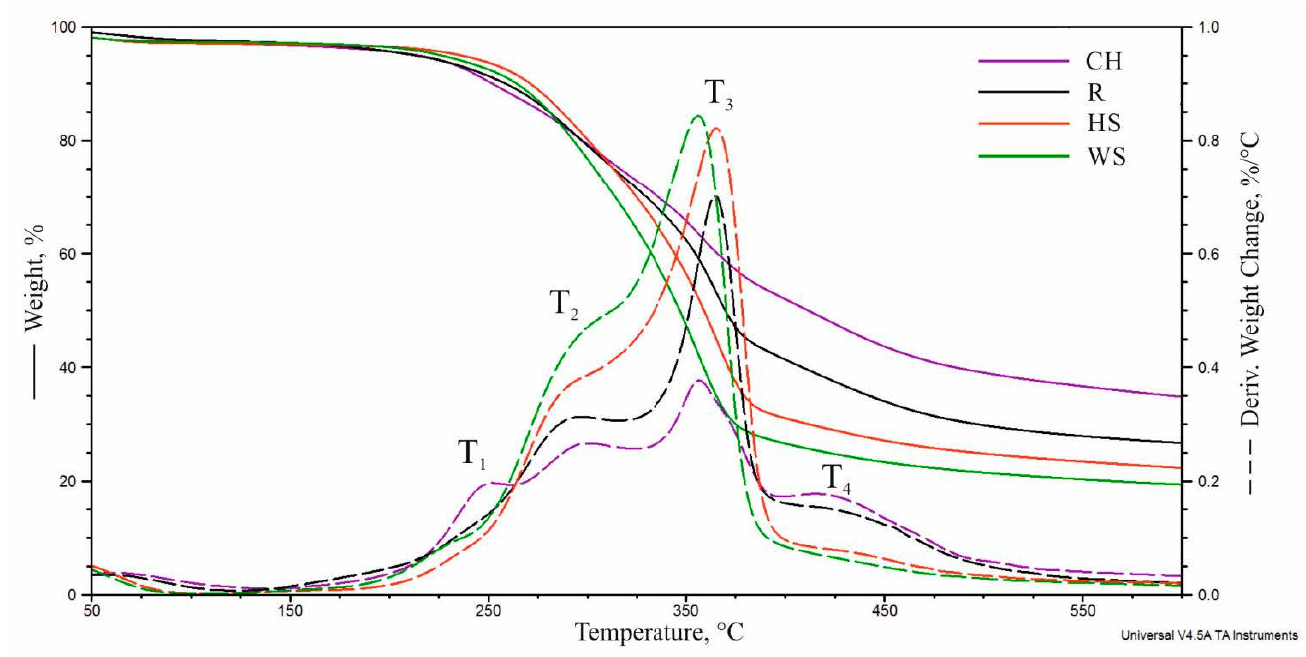
Figure 2. TG and DTG curves of the natural fillers.